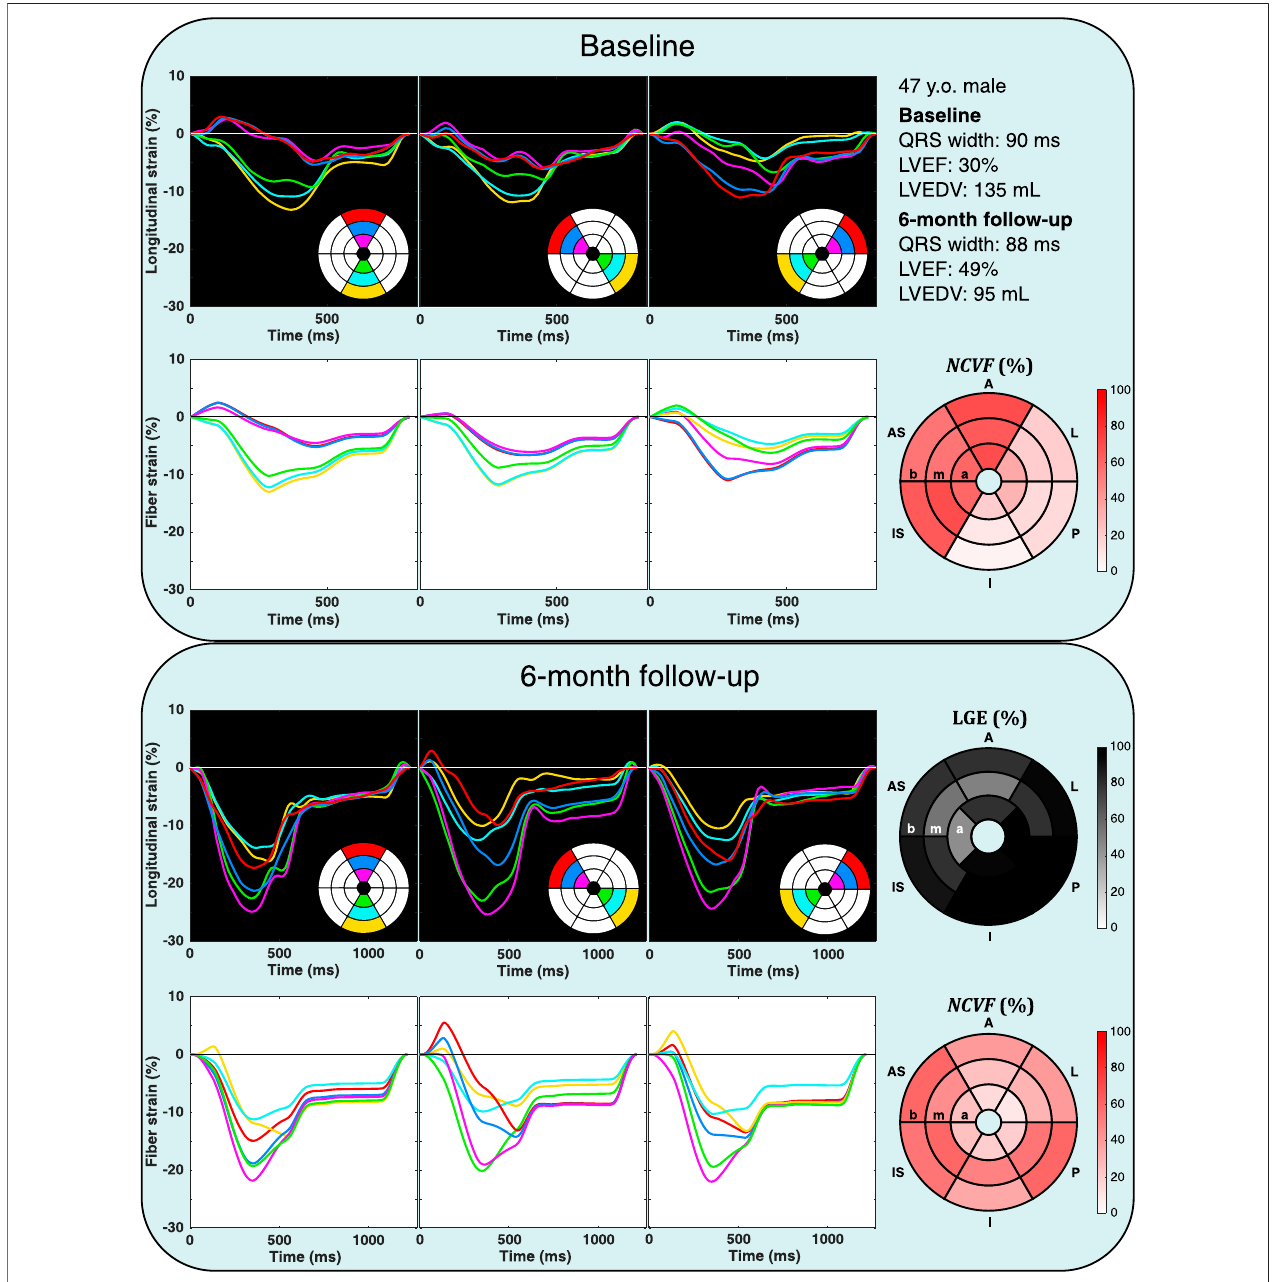
FIGURE 8 | Echocardiographic strain measurements (black panels) and simulated strain patterns obtained using an optimization algorithm (white panels) at the baseline and 6-month follow-up in one patient from the DEFI-MI subcohort (patient 1, a 47-year-old male). Estimated NCVF values at the baseline were higher in the anterior (A), anteroseptal (AS), and inferoseptal (IS) wall segments than in the rest of the heart. After 6 months, the scar tissue was found in the same area using late gadoliniumenhancement(LGE).Althoughcontractiledysfunctionremainedat6-monthfollow-up, NCVF valuesintheA,AS,andISsegmentswerelower.I,inferior; P, posterior; L, lateral; b, base; m, mid-ventricle; a, apex.